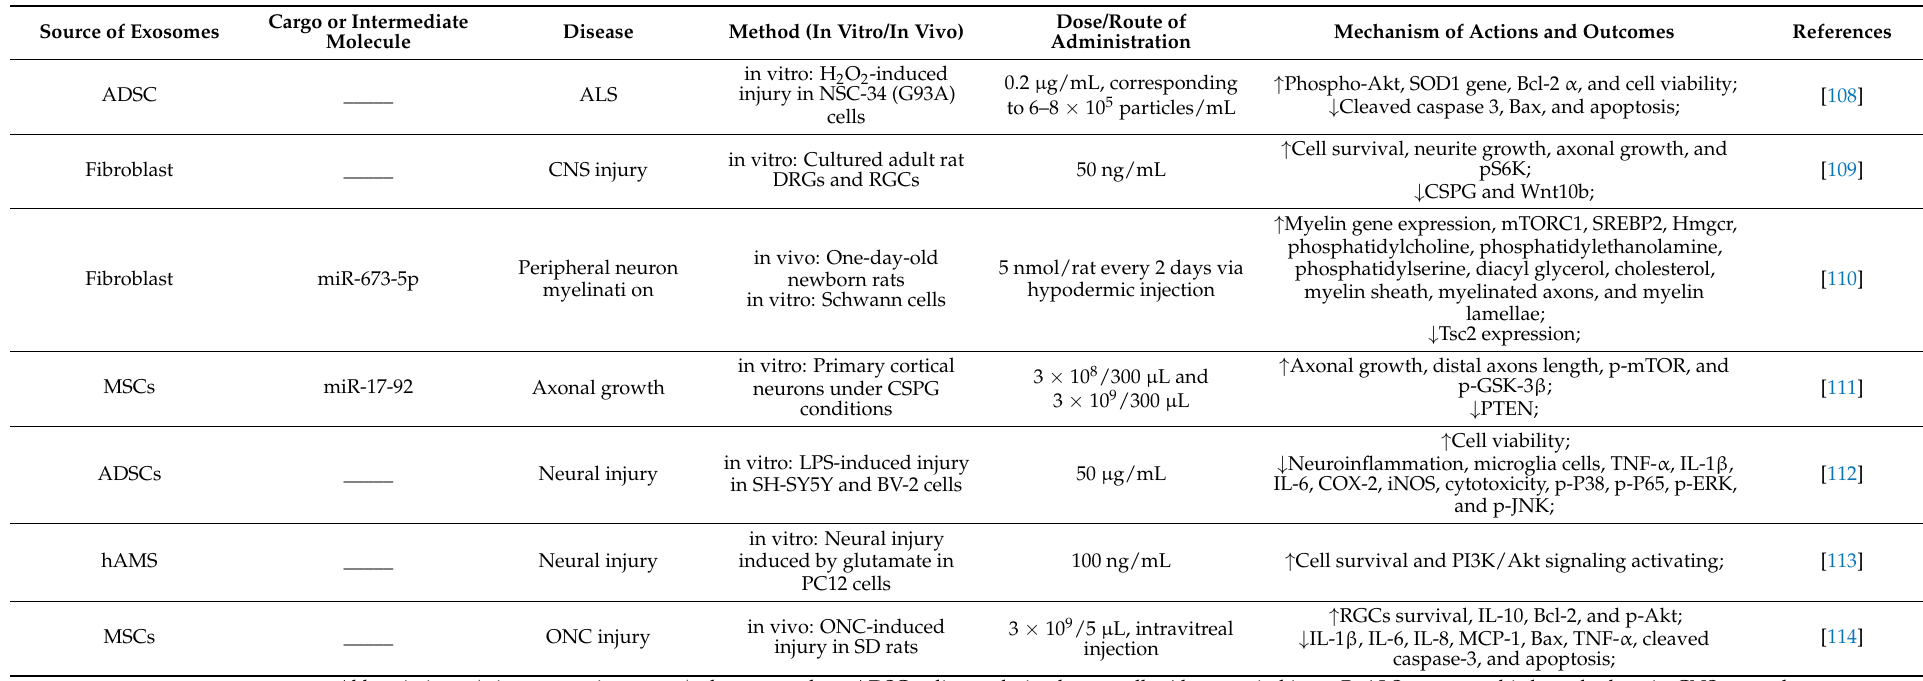
Table 3. Exosomes circumvent other neurological diseases via PI3K/Akt/mTOR and associated